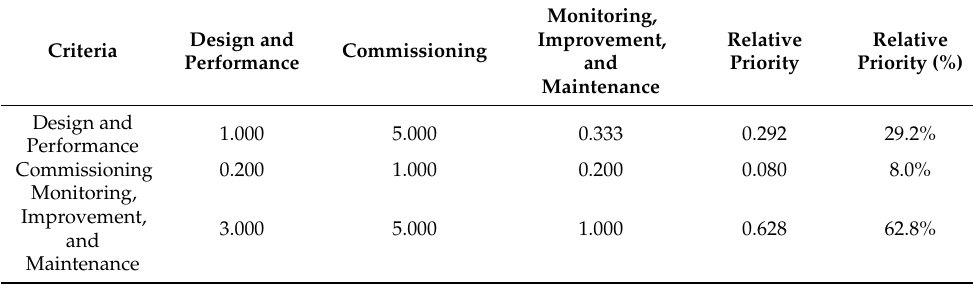
Table 6. Paired comparison matrix for the energy efficiency (EE) attribute in %.